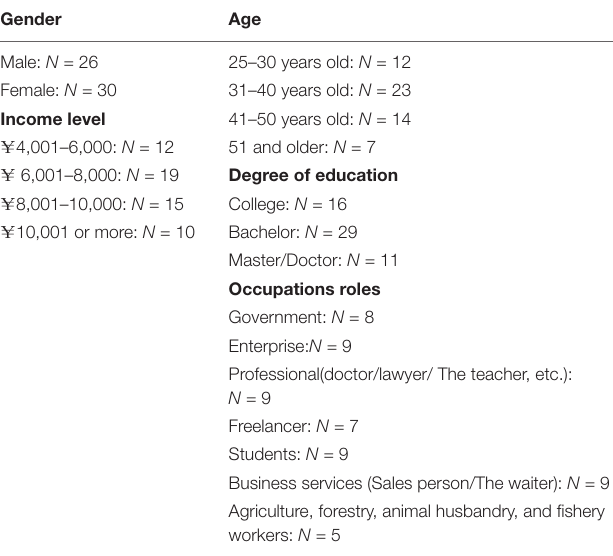
TABLE 1 | Basic description of